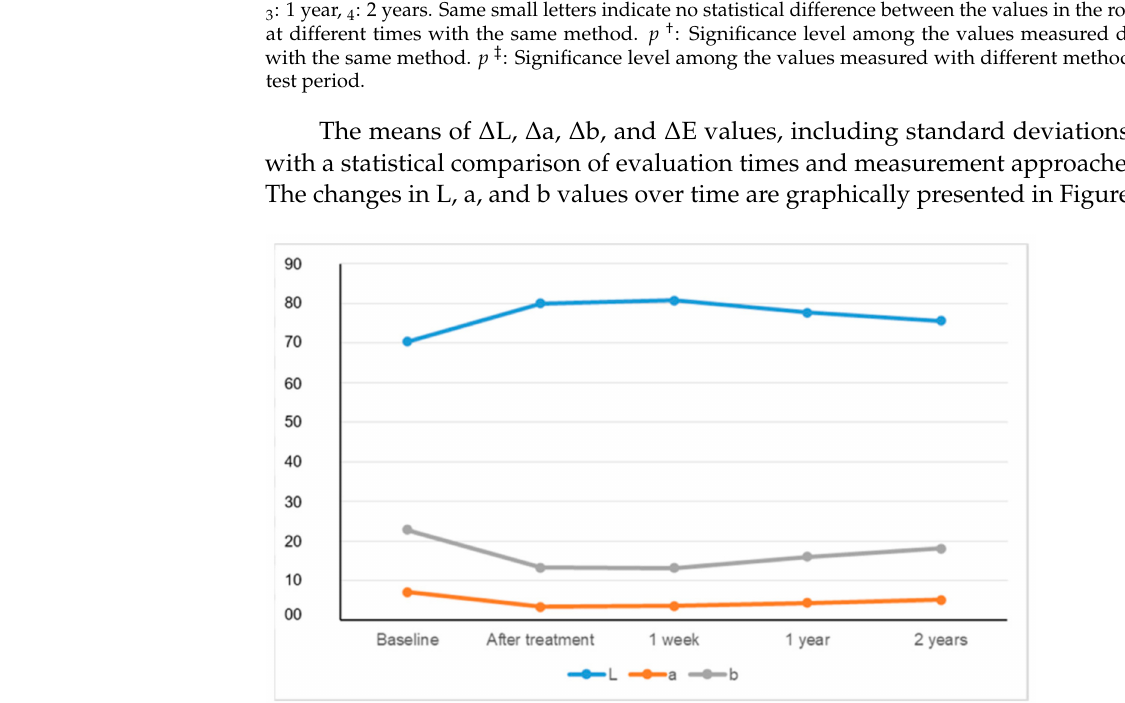
Figure 3. The change of CIEL*a*b* values measured by spectrophotometer over time. *Y-axis defines the numeric values of the parameters L, a, and